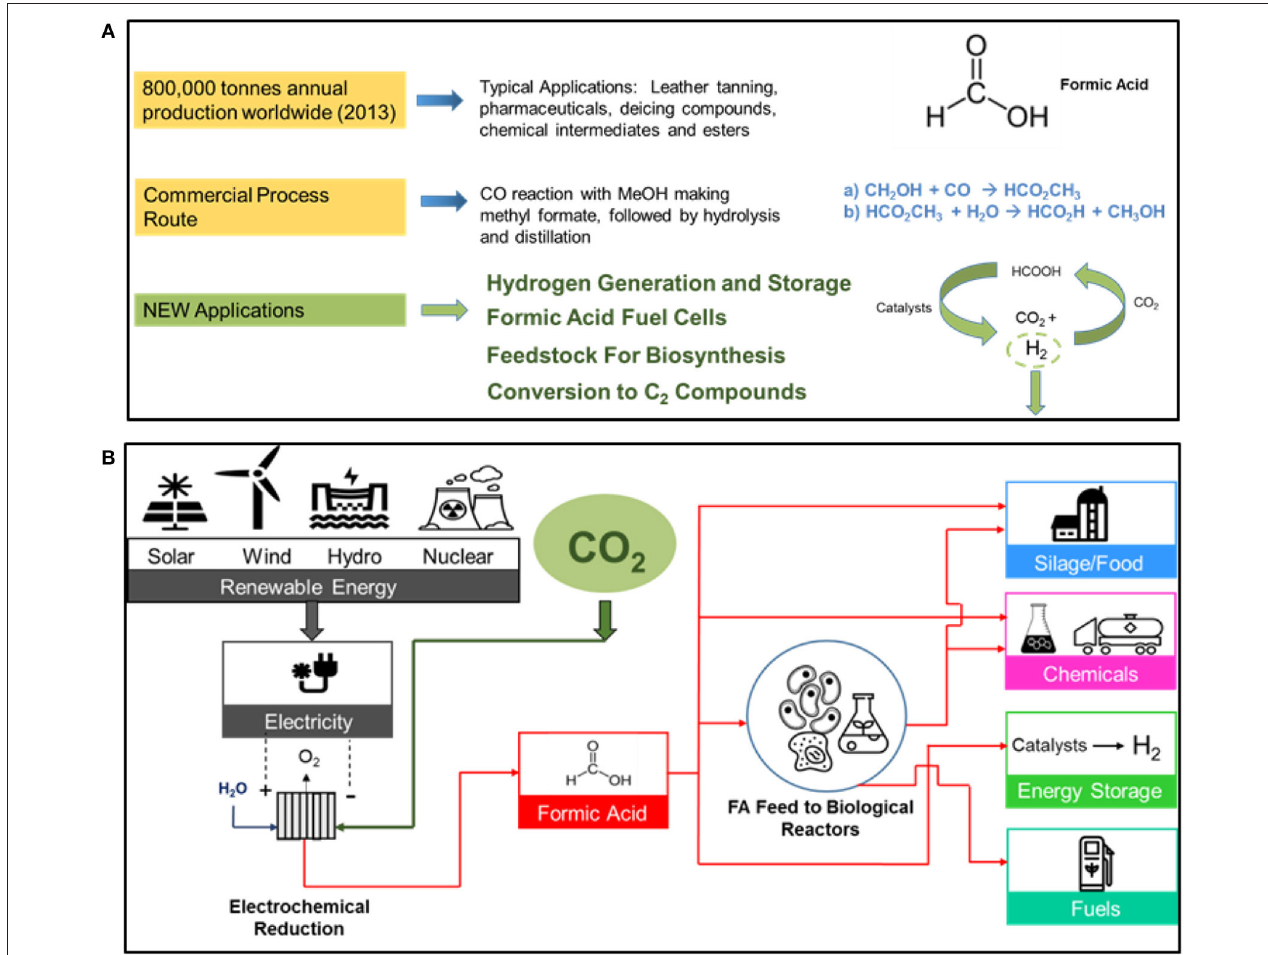
FIGURE 5 | The worldwide market for formic acid (2013) showing the current chemical commercial process route by the carbonylation of methanol, and some new FA applications is shown in (A) . A sustainable route to formic acid using renewable energy resources and manufacturing products in the various product categories is shown in (B)